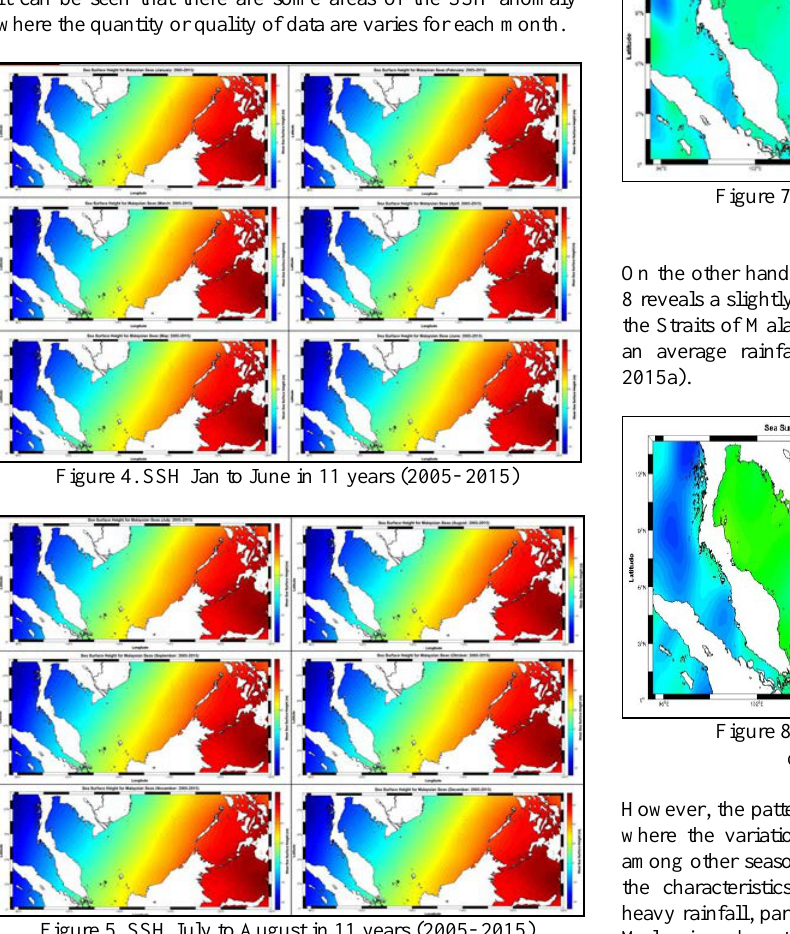
Figure 5. SSH July to August in 11 years (2005- 2015) 3.2